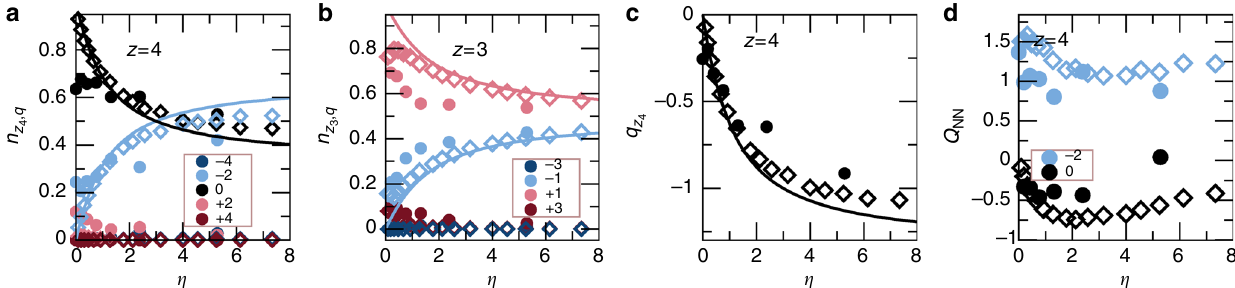
= N z = 4 vertices grouped by topological at equilibrium vs η ¼ N z z 4 for 4 ; q 3 vs. η for z = 3 vertices. Dark blue: 3 ; q and n z tend to the same value of 3 ; q ¼ 1 3 ; q ¼(cid:2) 1 z = 4 vertices vs η as a measure of ice rule violation. z 4 forming on